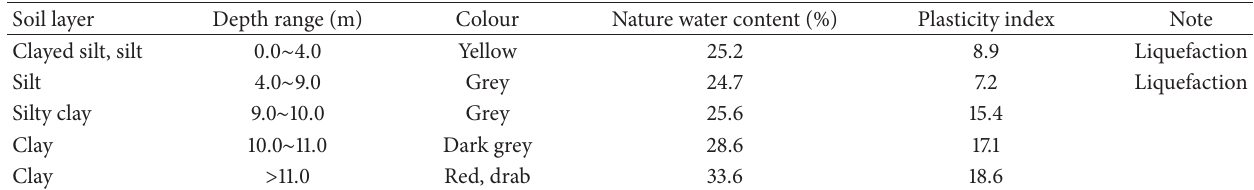
Table 1: Soil profile at the site (sourced from Miao et al. 2006